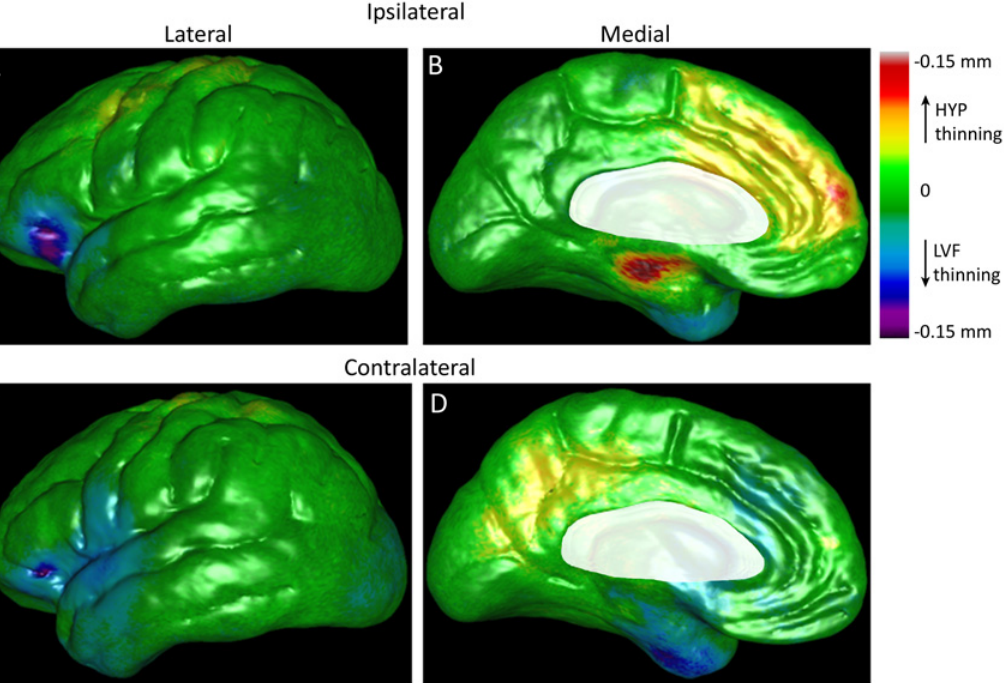
Fig 5. Beta maps illustrating the magnitude of the interaction between ictal EEG onset pattern and epilepsy duration on cortical gray matter thickness after controlling for age and gender. Lateral (left column) and medial surfaces (right column) of cerebral hemisphere ipsilateral (top row) and contralateral to the SOZ (bottom row). Cortical areas colored yellow, orange, and red indicate thinner GM (in mm) per year of epilepsy in patients with HYP onset seizures, whereas areas colored blue, indigo, and violet correspond to reduced GM per year of epilepsy in patients with LVF onset seizures. Shades of green depict areas of minimal or no thinning per year of disease (color-coded scale upper right corner). Permutation tests correcting for multiple comparisons were significant (ipsilateral: p = 0.037, contralateral: p = 0.037). Areas masked in white are brain areas not applicable for this